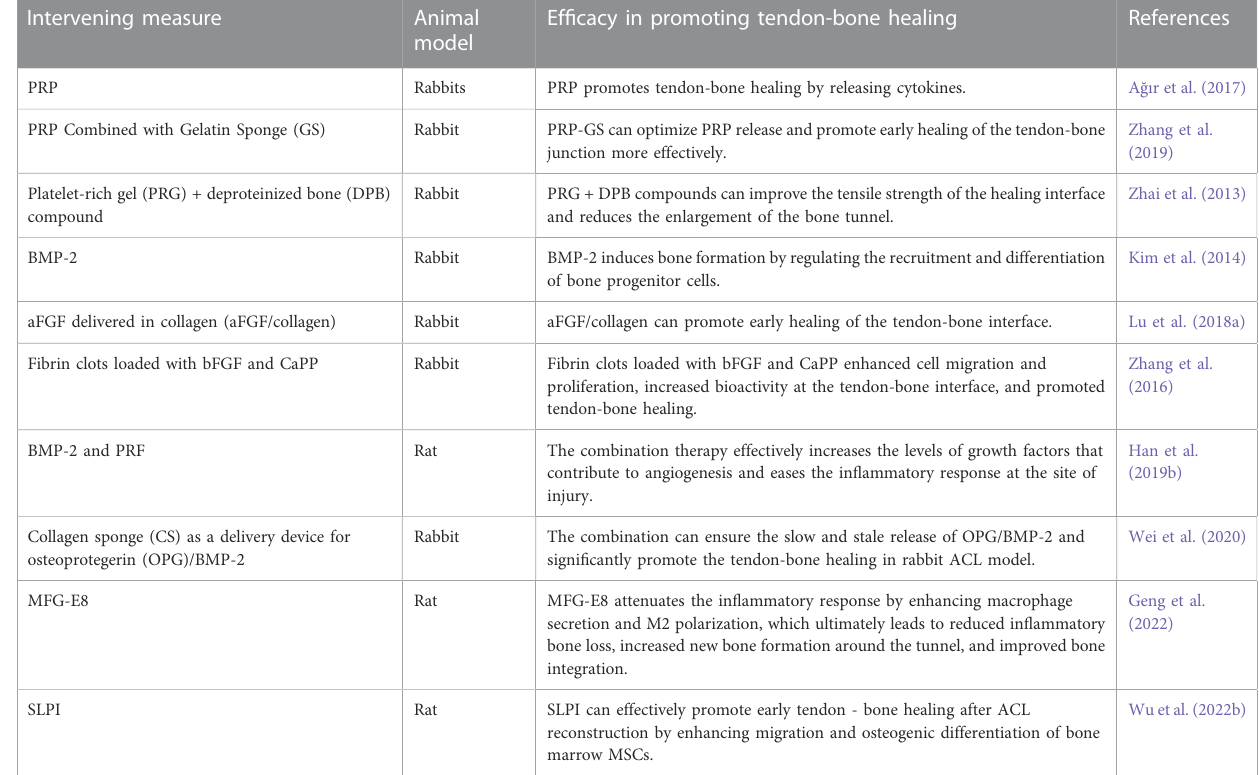
TABLE 4 Preclinical studies of cytokines in promoting tendon-bone healing in ACL reconstruction. Intervening